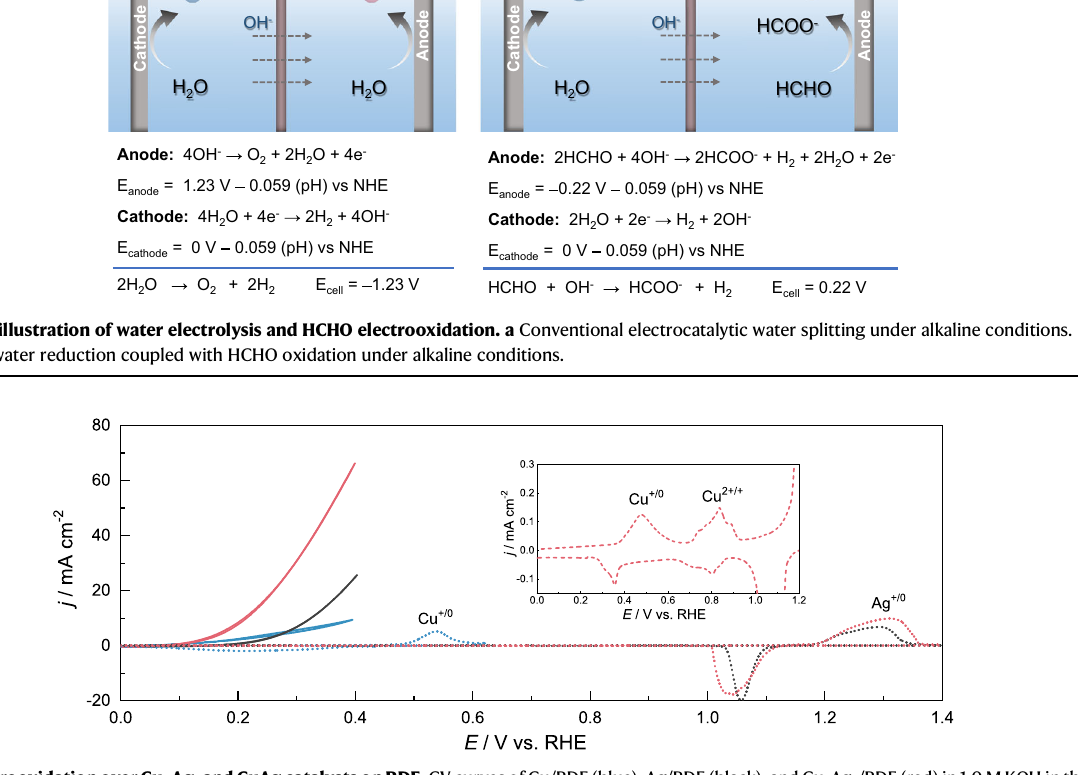
Fig.2|HCHOelectrooxidationoverCu,Ag,andCuAgcatalystsonRDE. CVcurvesofCu/RDE(blue),Ag/RDE(black),andCu 3 Ag 7 /RDE(red)in1.0MKOHintheabsence (dashed) and presence (solid) of 0.6M HCHO collected at 1500rpm and 10mV/s. Inset shows the expanded CV of copper oxidation on Cu 3 Ag 7